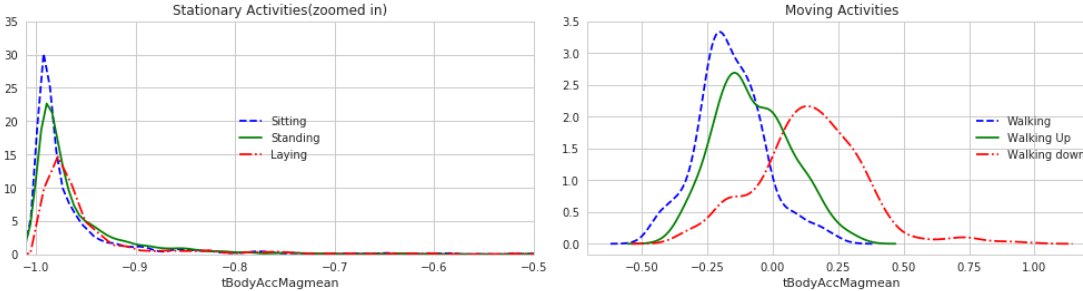
Figure 5. Curve of acceleration change (before preprocessing).